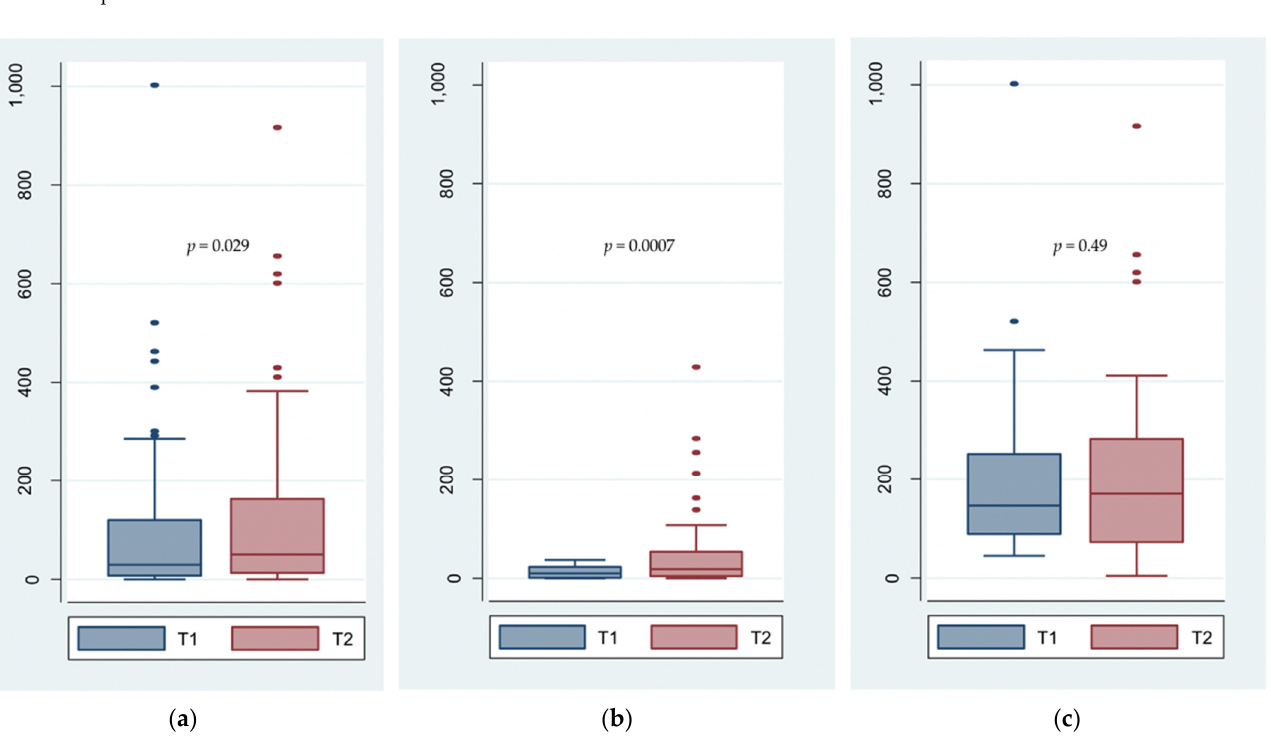
Table 4. Impact of patients’ characteristics on the total sperm number (TSN) (10 6 /ejaculate) before and after varicocele embolization (VE).